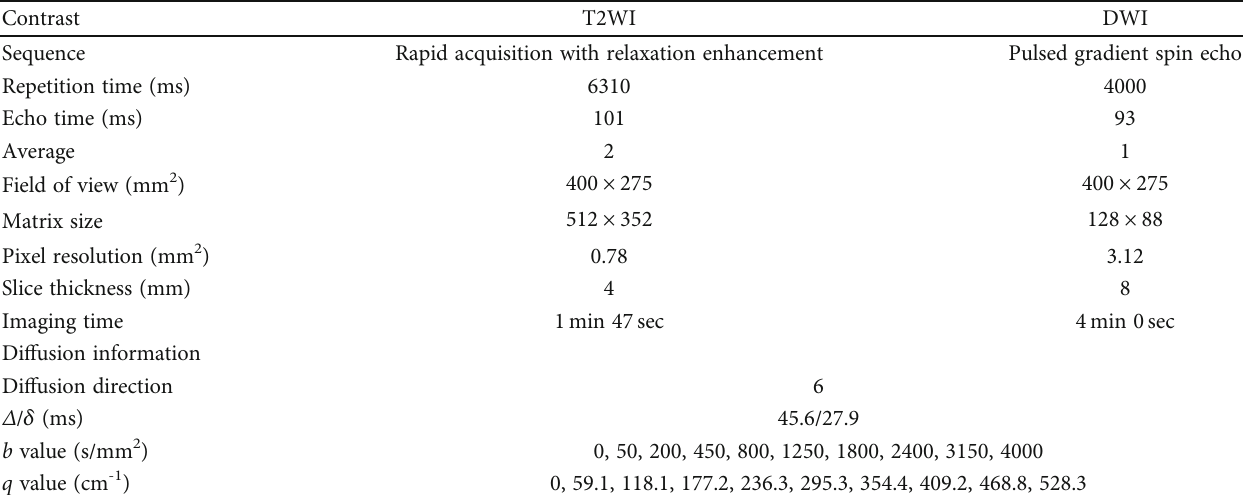
Table 1: Summary of the magnetic resonance imaging protocol.